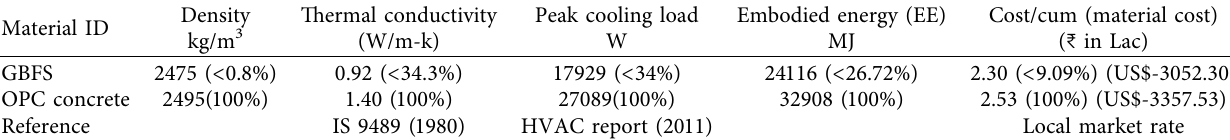
Table 7: Comparative study of material along with thermal